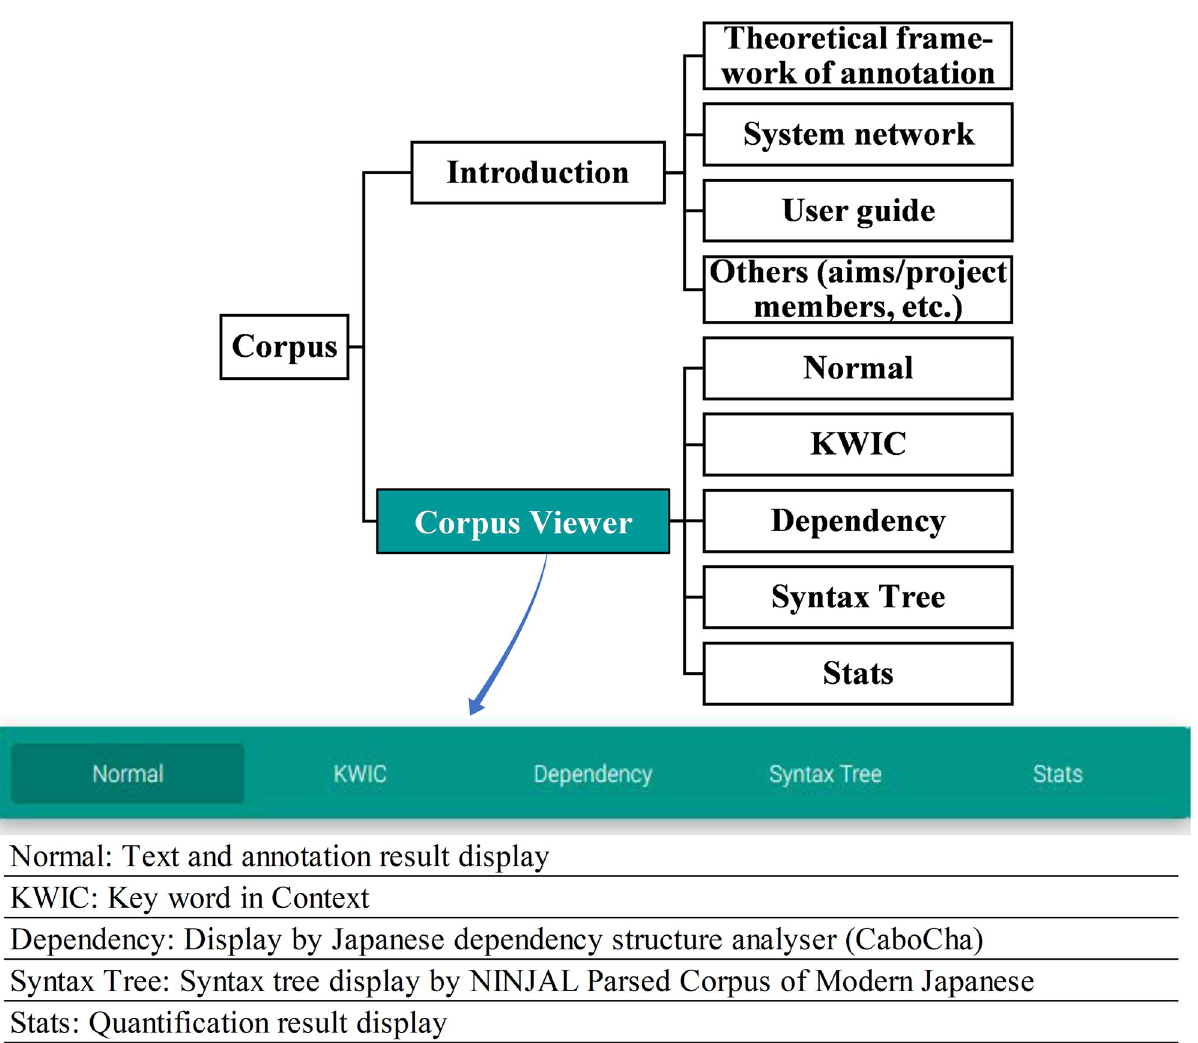
Fig 11. The structure of the corpus. The corpus is divided into two main parts, the Introduction and the Corpus Viewer. The Corpus Viewer incorporates the search and results display